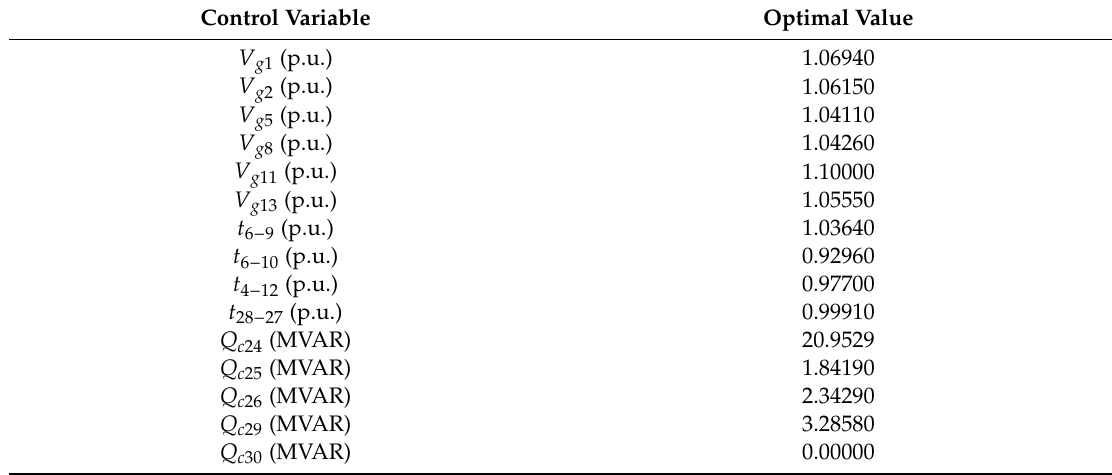
Table 6. The optimal values of the control variables for the deterministic multi-objective RPP without considering the loadability